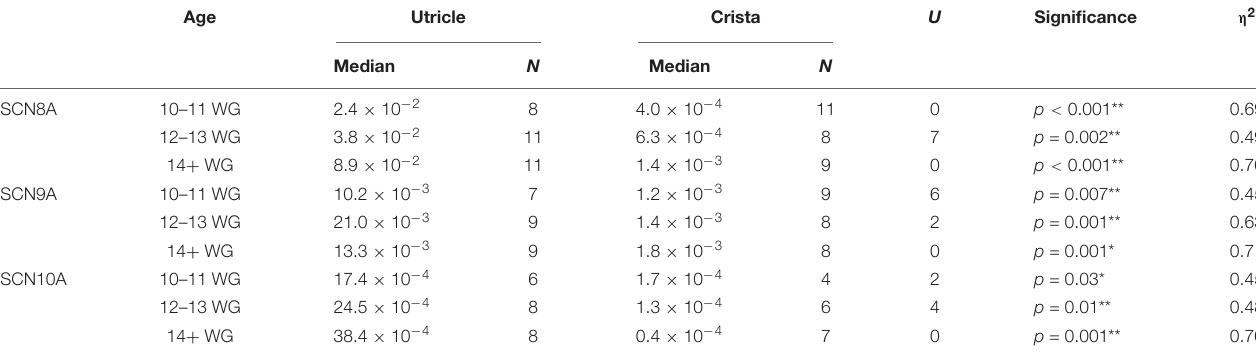
TABLE 3 | Relative expression of SCN8A, SCN9A, and SCN10A in utricle compared to cristae ampullares during fetal development. Age Utricle Crista U Significance